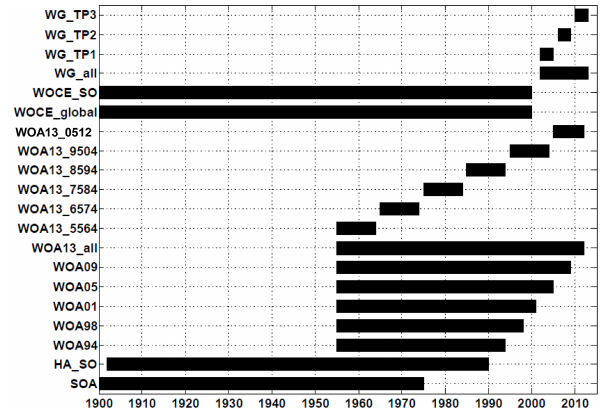
Figure 23. A plot showing the time spans of a list of climatologies, including the time spans of the data set provided here; WG_all rep- resents the gridded fields of the entire time span, while WG_TP1, WG_TP2 and WG_TP3 represent the time spans of the gridded fields for TP1, TP2 and TP3 respectively.